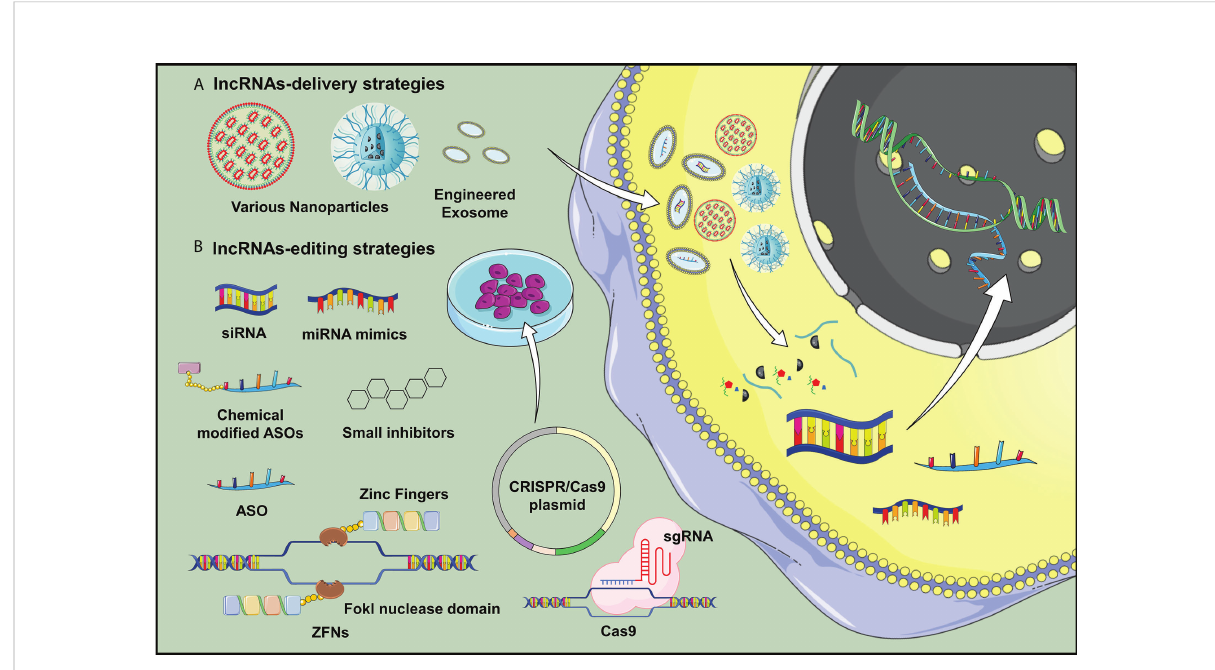
FIGURE 2 Potential delivery strategies for lncRNA H19 is proposed in OA treatment. (A) Nanotechnology and lncRNA-loaded exosomes could overcome the low ef fi ciency of in vivo transgene lncRNA transfection, which would be applicable for widespread clinical application of gene